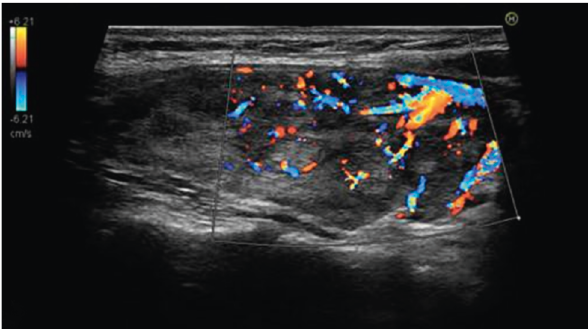
Figure 1: Color Doppler ultrasound grading of hyperthyroidism level 1.